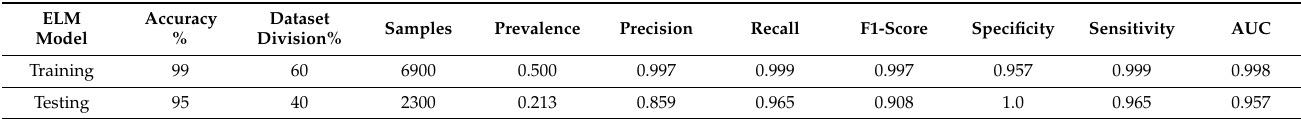
Table 6. ELM Performance Parameters for Experiment # 3.